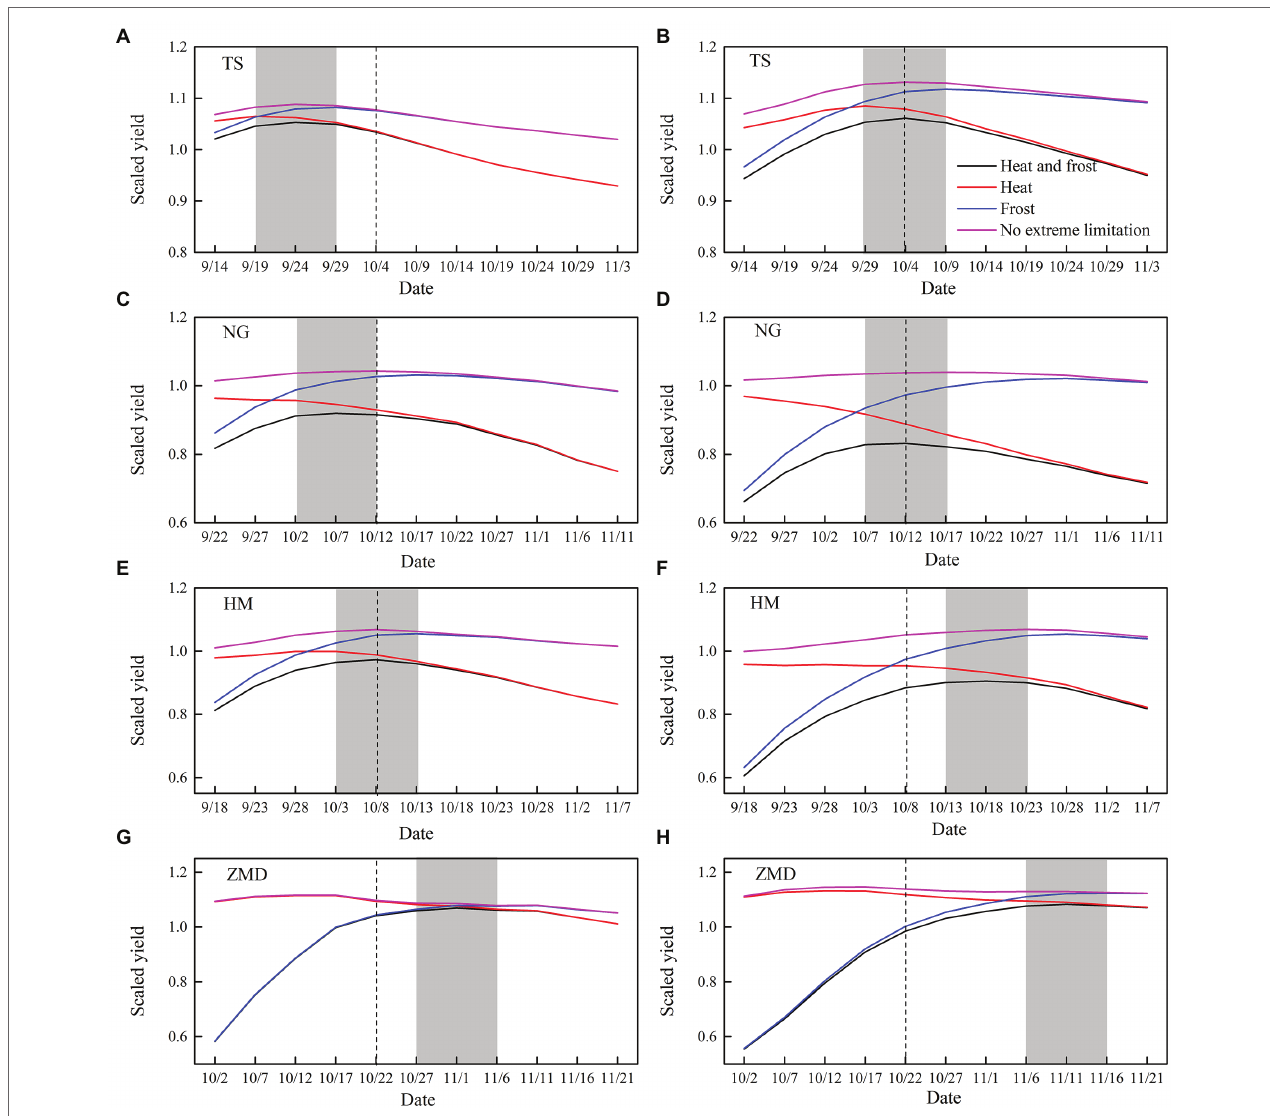
FIGURE 8 | Yield performance considering heat and frost stress in the different sowing dates during the 2040S (A,C,E,G) and 2080S (B,D,F,H) under SSP245 scenario. The black dotted line is the historical sowing date. The gray rectangle is the optimum sowing window. All the yields have been normalized by historical yield without the effect of extreme temperature